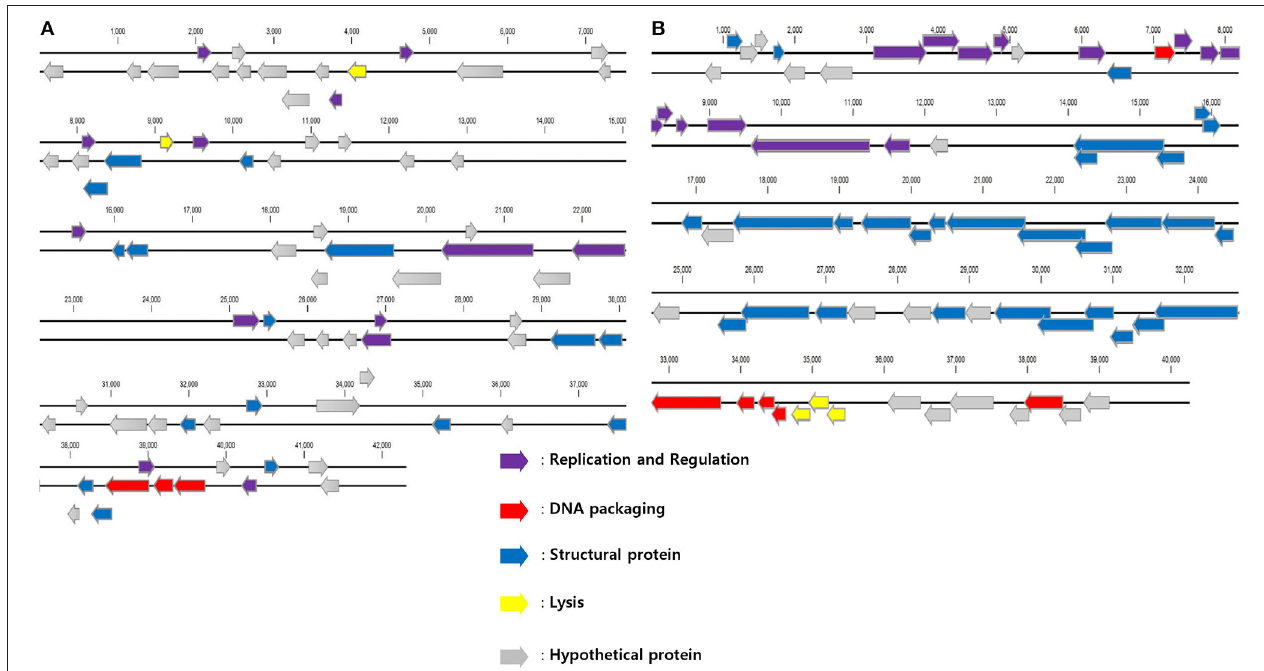
FIGURE 4 | Putative open reading frame (ORF) map of phages PBAB08 (A) and PBAB25 (B) . ORF map was drawn using CLC Genomics Workbench 10. Each arrow is color-coded according to annotated genomic